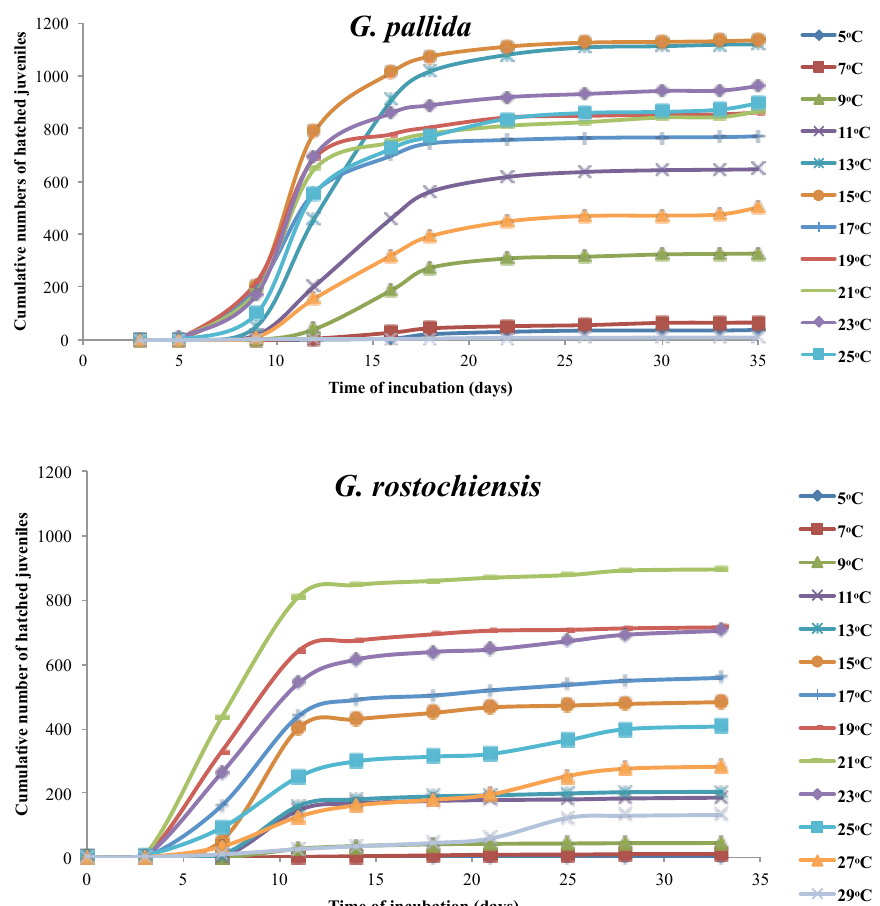
Figure 2. Mean cumulative numbers of juveniles hatched at different temperatues from ten cysts of Globodera rostochiensis (a) or G. pallida (b) in potato root diffusate during 35 d of